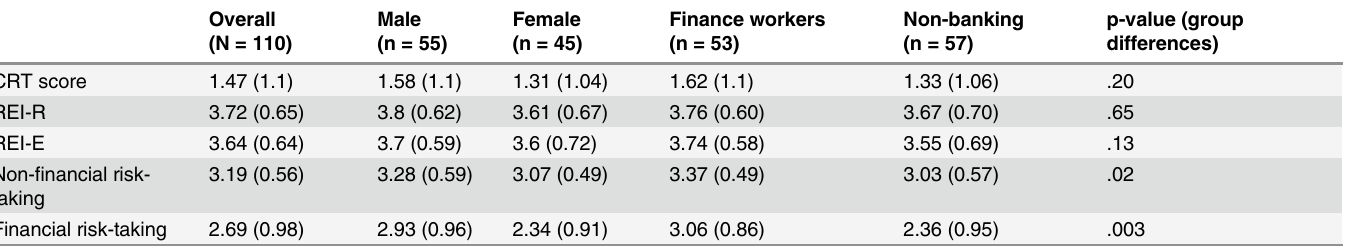
Table 2. Mean scores (and standard deviations) for risk-taking, cognitive reflection, and propensity for rational vs. experiential thinking style in